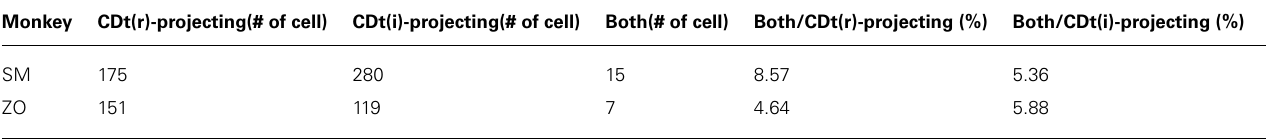
Table 4 | Numbers of SNc neurons projecting to rostral CDt, intermediate CDt, and both. Monkey